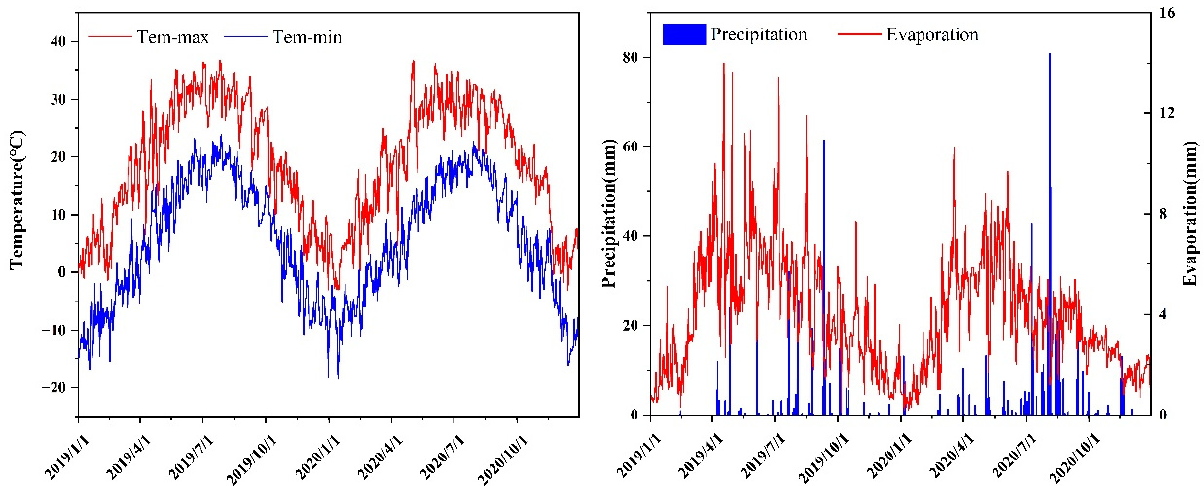
Figure 1. Daily maximum air temperature (Tem-max), minimum air temperature (Tem-min), precipitation and evaporation during experimental year 2019–2020.